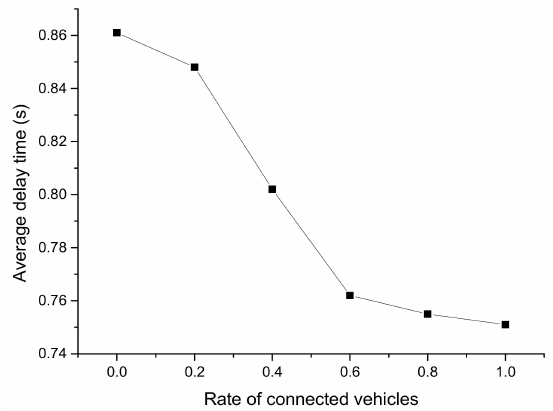
Figure 11. Average travel time from 500 to 600 s with di ff erent CV rates.